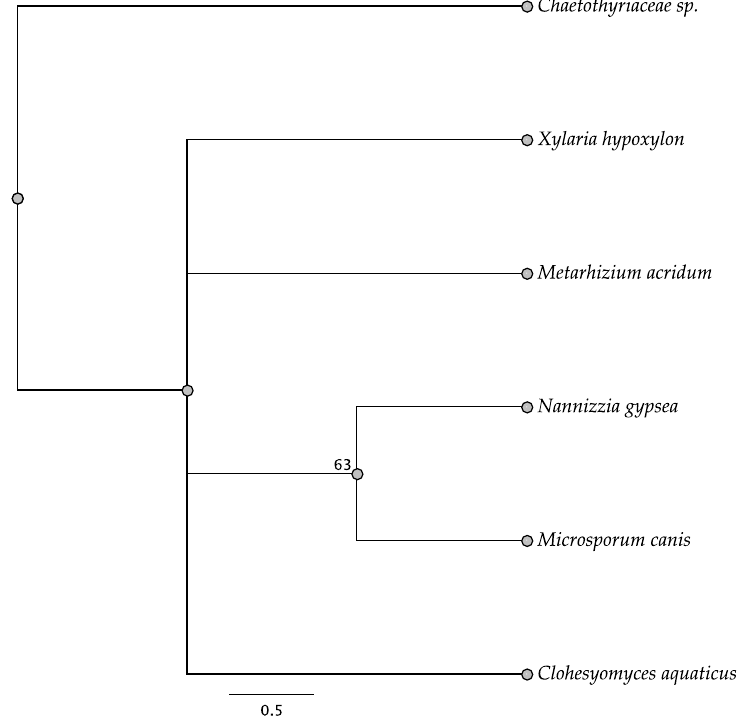
Figure 12. Maximum parsimony DNA tree resulting from the analysis of the swnK – swnR intergenic region sequence data. Bootstrap confidence values from 1000 bootstrap replicates are presented at each corresponding node. Fungal orders are indicated next to each organism/clade.